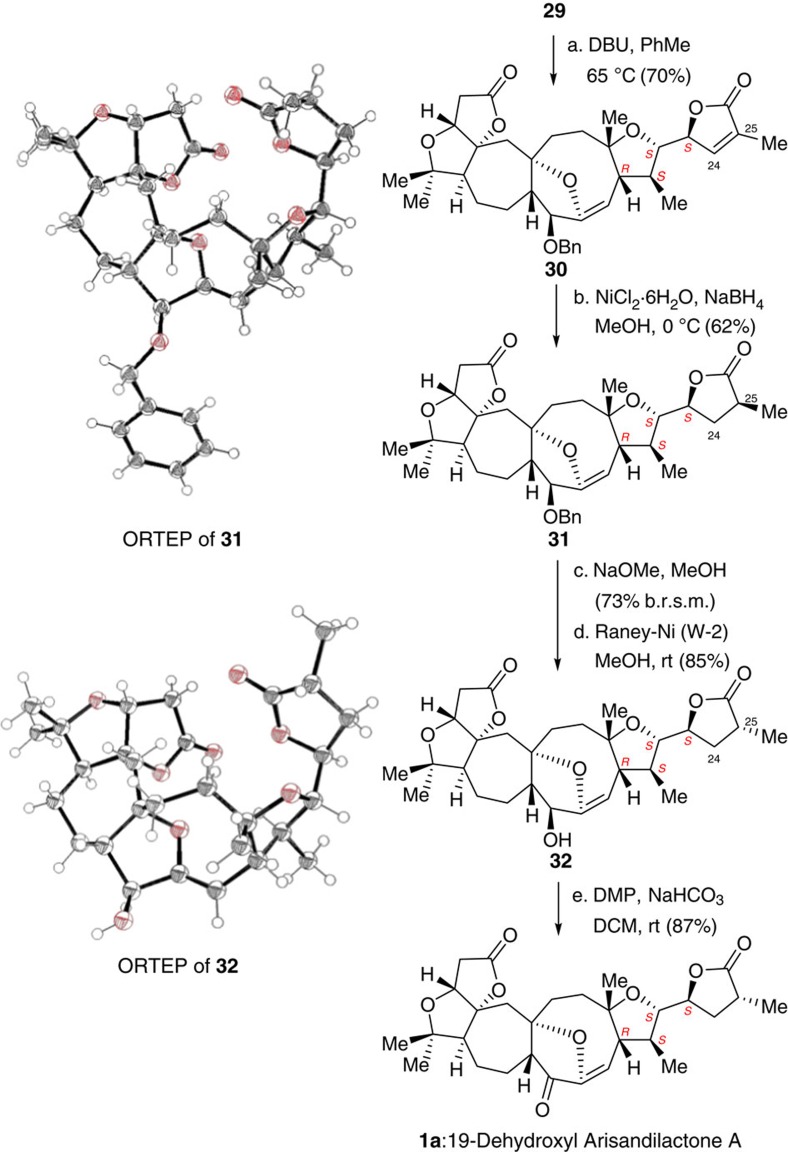
Total synthesis of 19-dehydroxyl-arisandilactone A (1a).(a) DBU (15.0 eq), PhMe, 65 °C, 70%; (b) NiCl2·6H2O (1.0 eq), NaBH4 (3.0 eq), MeOH, 0 °C, 62%; (c) 5% NaOMe/MeOH, rt, 73% (b.r.s.m.); (d) W-2 Raney Ni, EtOH, rt, 85%; (e) DMP (2.0 eq), NaHCO3 (5.0 eq), DCM, rt, 87%. b.r.s.m., based on recovered starting material; DMP, Dess-Martin periodinane.